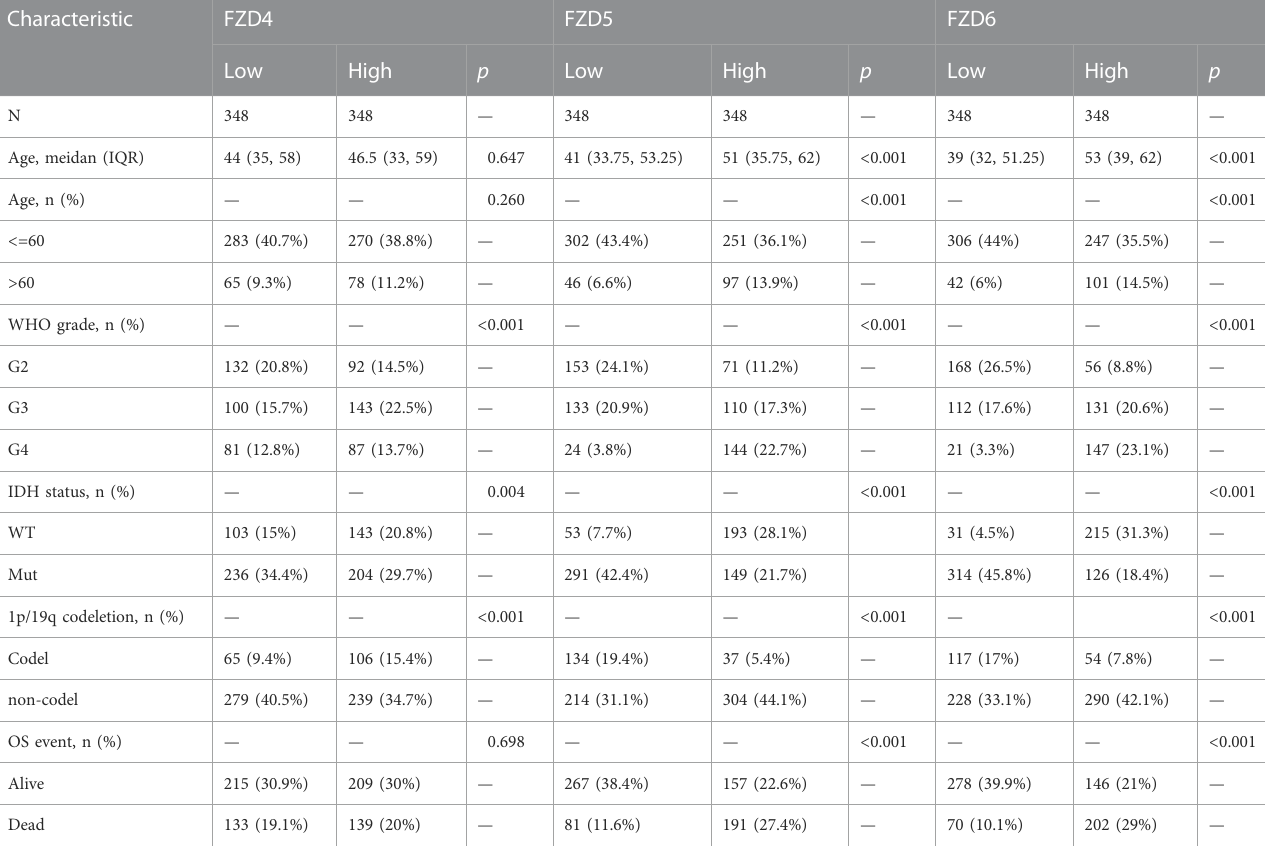
TABLE 2 The FZDs expressions in glioma patients with different clinical parameters.